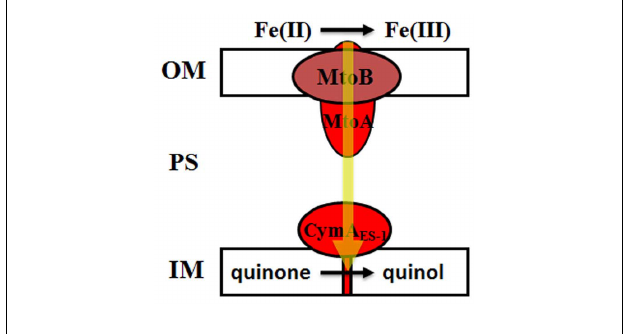
FIGURE 10 |The proposed roles of MtoAB and CymA ES-1 in Sideroxydans lithotrophicus ES-1-mediated extracellular Fe(II) oxidation. Decaheme c -Cyt MtoA, which is inserted into the porin-like, outer membrane (OM) protein MtoB, oxidizes Fe(II) directly on the bacterial surface and transfers the released electrons across the OM to the periplasmic proteins that have yet to be identified.The periplasmic proteins relay the electrons through the periplasm (PS) to the tetraheme c -Cyt CymA ES-1 . CymA ES-1 , a homolog of NapC/NrfH family of quinol dehydrogenase that is located in the cytoplasmic or inner membrane (IM), reduces quinone to quinol. c -Cyts are labeled in red and direction of electron transfer is indicated by a yellow